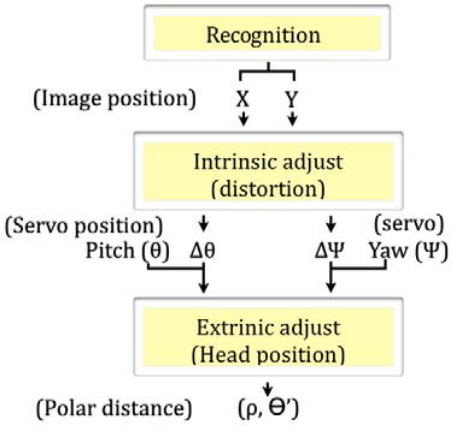
Figure 9. Diagram for object-to-robot distance